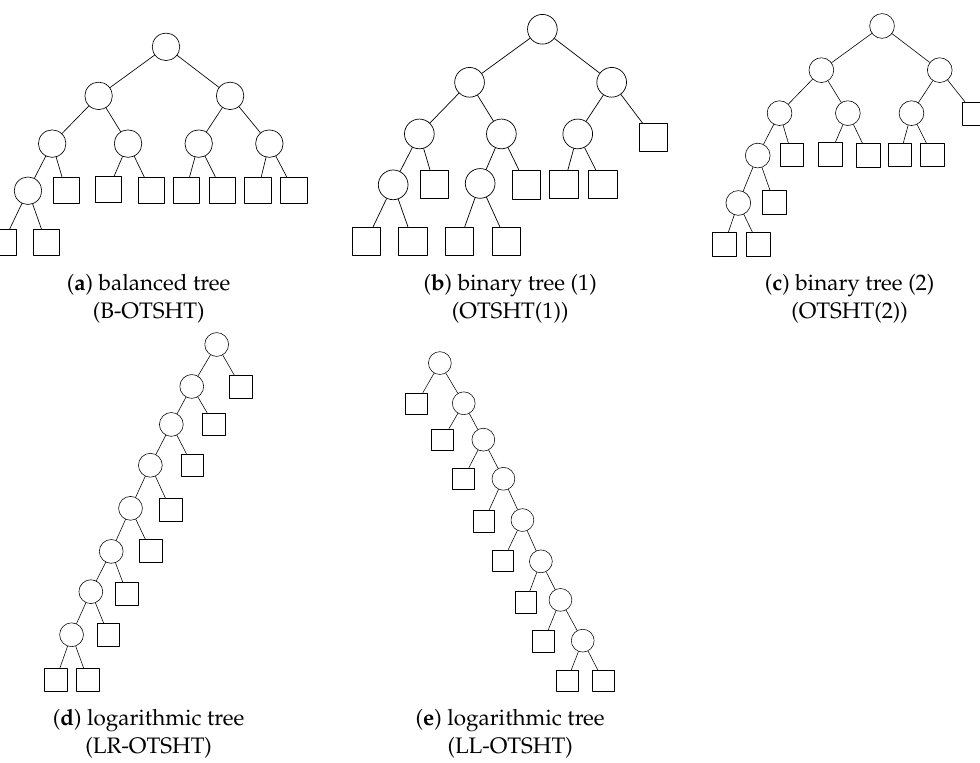
Figure 8. Five examples of binary tree having nine